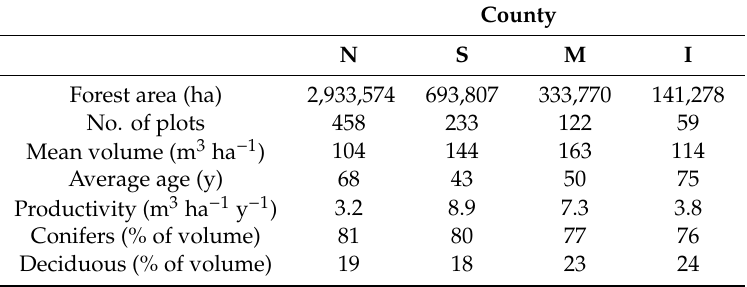
Figure 2. The location of study counties Västerbotten (N), Kronoberg (S), Västmanland (M), and Gotland (I) and the facilities heating plants, pulp mills, and sawmills.